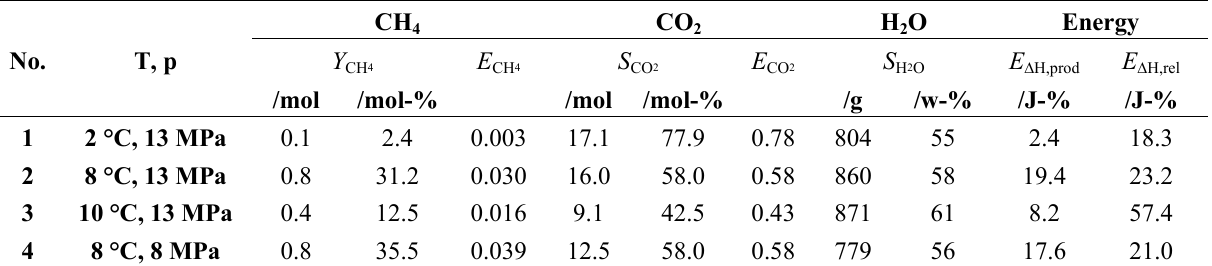
Table 5. Summary of results: Mass and energy based process efficiencies and yields. CH No. T, p